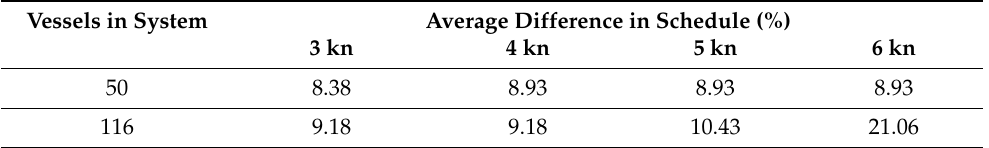
Table 8. Icebreaker assistance threshold